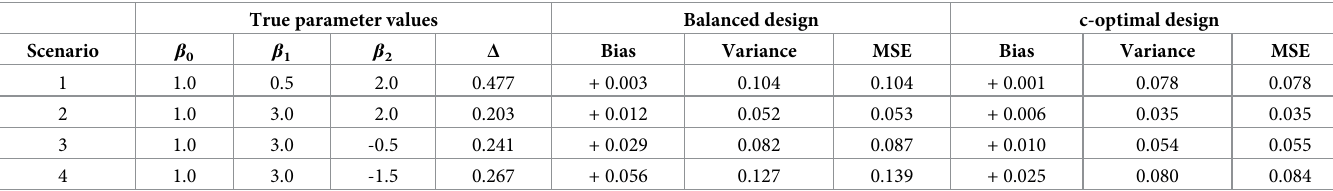
Table 1. Simulation